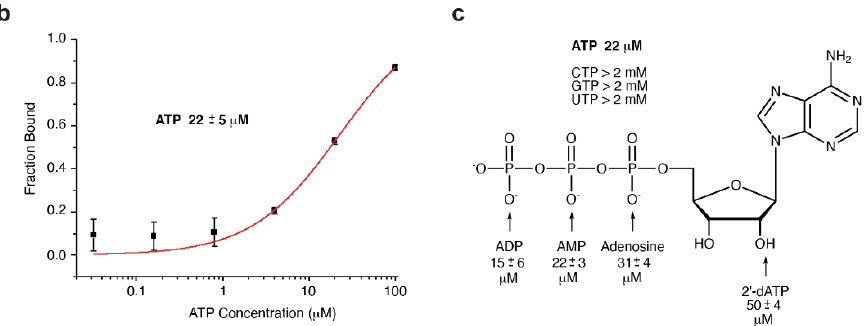
Figure 3. Solution binding a ffi nity (Kd) of the ATP-binding TNA aptamer to free ATP and other closely related nucleoside triphosphates. All binding assays were performed using the minimal sequence (10-7.t5) TNA aptamer prepared by solid-phase synthesis. Binding measurements were performed in binding bu ff er containing 5 mM MgCl 2 , 300 mM NaCl, and 20 mM Tris-HCl (pH 7.6) at 24 ◦ C. ( a ) Aptamer sequence. ( b ) Binding isotherm obtained for ATP. ( c ) Summary of Kd values obtained for other nucleoside triphosphates and ATP analogs.